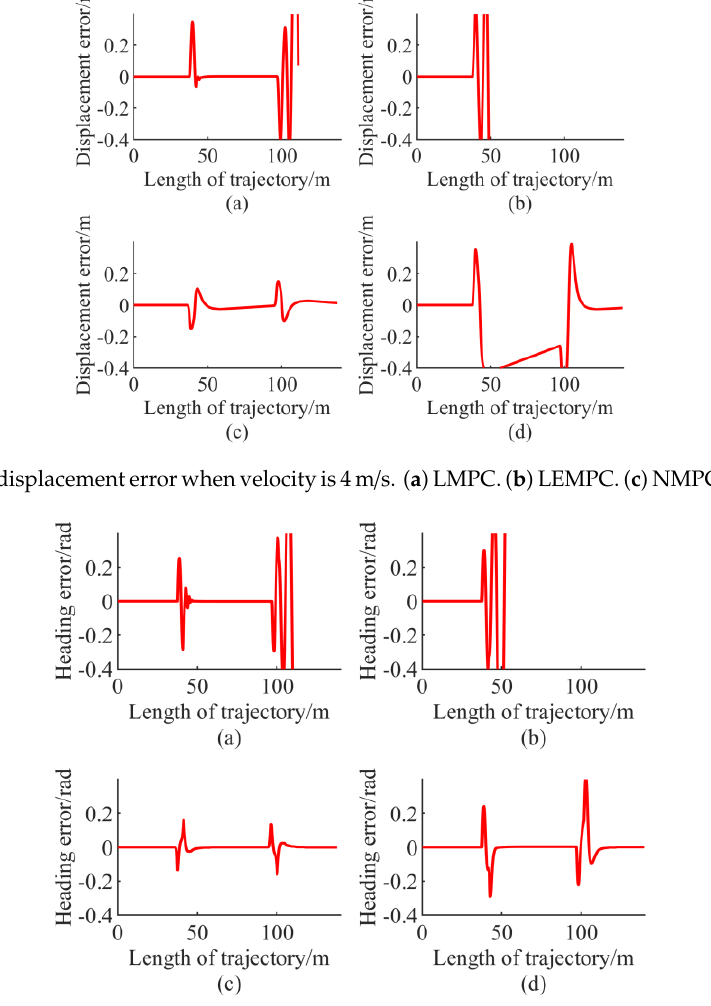
Figure 17. The heading error when velocity is 4 m/s. ( a ) LMPC. ( b ) LEMPC. ( c ) NMPC. ( d ) NEMPC.